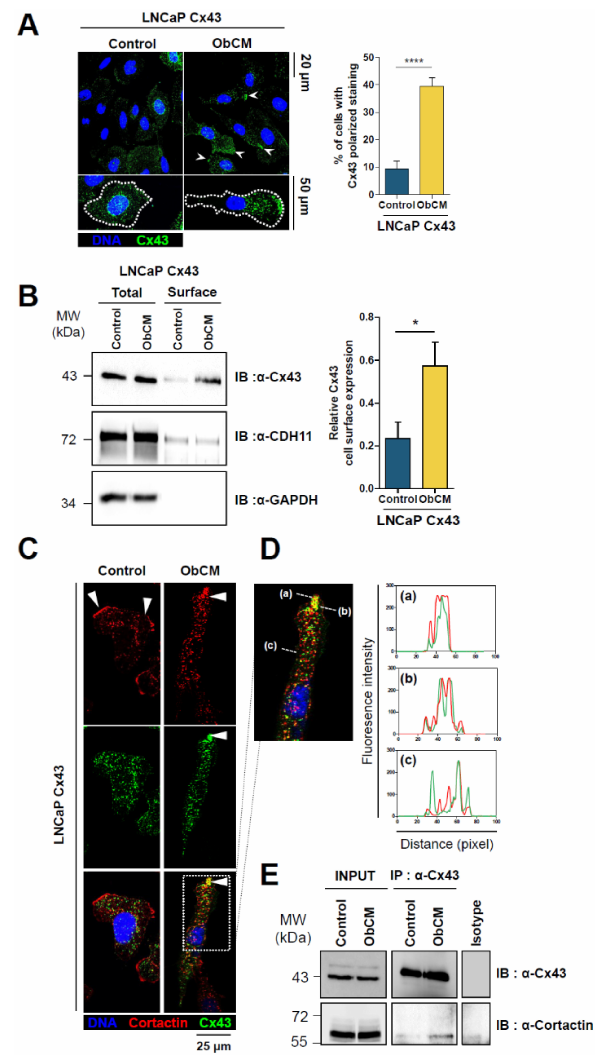
Figure 8. Cx43 enriched upon ObCM stimulation colocalizes in lamellipodia with Cortactin. ( A ) (Left) Immunostaining of Cx43 (green) in LNCaP Cx43 cells after 17 h of stimulation with or without ObCM; nuclei were DAPI-stained (blue). White arrowheads show areas of accumulated staining corresponding to the front of migration of cells, e.g., lamellipodia. Enlarged images show higher magnification of Cx43 staining in the 2 conditions. (Right) Quantification of the percentage of cells with Cx43 staining being polarized to the leading edge of the cells (CTRL, n = 89; ObCM, n = 169). ( B ) Representative immunoblot (left) and densitometric quantification (right) after surface biotinylation assay showing an increase in Cx43 enrichment at the surface of LNCaP Cx43 cells after 17 h of incubation with ObCM. Pre- (total) and post-Streptavidin pull down protein lysates (Surface) from LNCaP Cx43 CTRL and LNCaP Cx43 ObCM were immunoblotted with indicated antibodies. Cadherin 11 served as a positive control of cell surface expression. Data represent the mean ± SEM from 3 di ff erent experiments. ( C ) Co-immunostaining of Cx43 (green) and cortactin (red) in LNCaP Cx43 cells after 17 h of stimulation with or without ObCM; nuclei were DAPI-stained (blue). ( D ) Enlarged image shows higher magnification of Cx43 and cortactin staining in LNCaP Cx43 cells stimulated with ObCM. Fluorescence intensity profiles along the segments ( a – c ) suggest a colocalization of Cx43 with Cortactin at the leading edge of the cells. ( E ) Interaction between Cx43 and cortactin in LNCaP Cx43 was assessed by immunoprecipitation 17 h after stimulation of cells with or without ObCM. Pre- (total) and post-immunoprecipitation protein cell extracts were immunoblotted with indicated antibodies. Isotype refers to immunoprecipitation control with irrelevant antibodies. * p < 0.05; **** p <